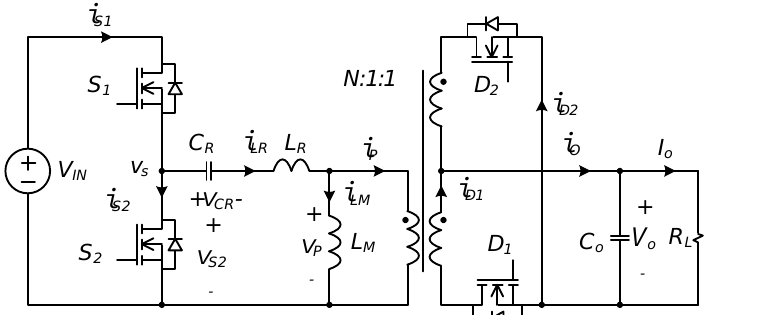
Figure 16. Basic schematic for experimental circuit.